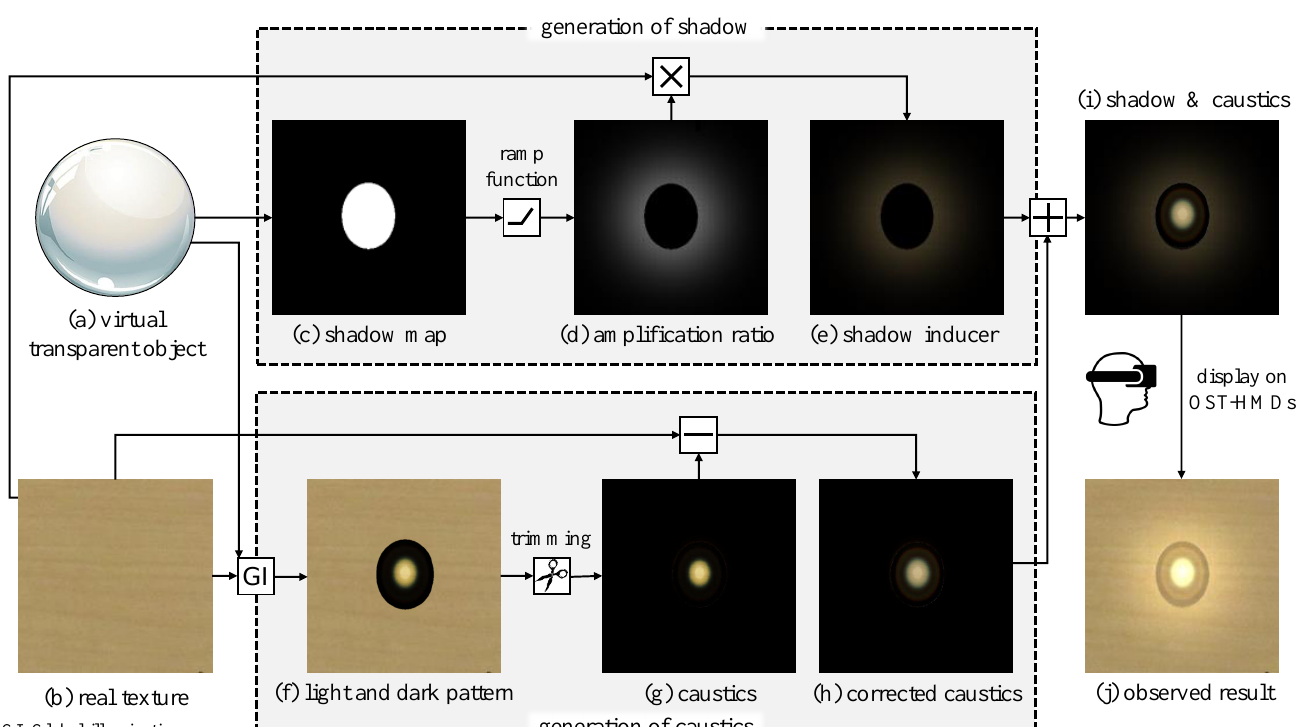
Figure 2. Process for generating shadow and